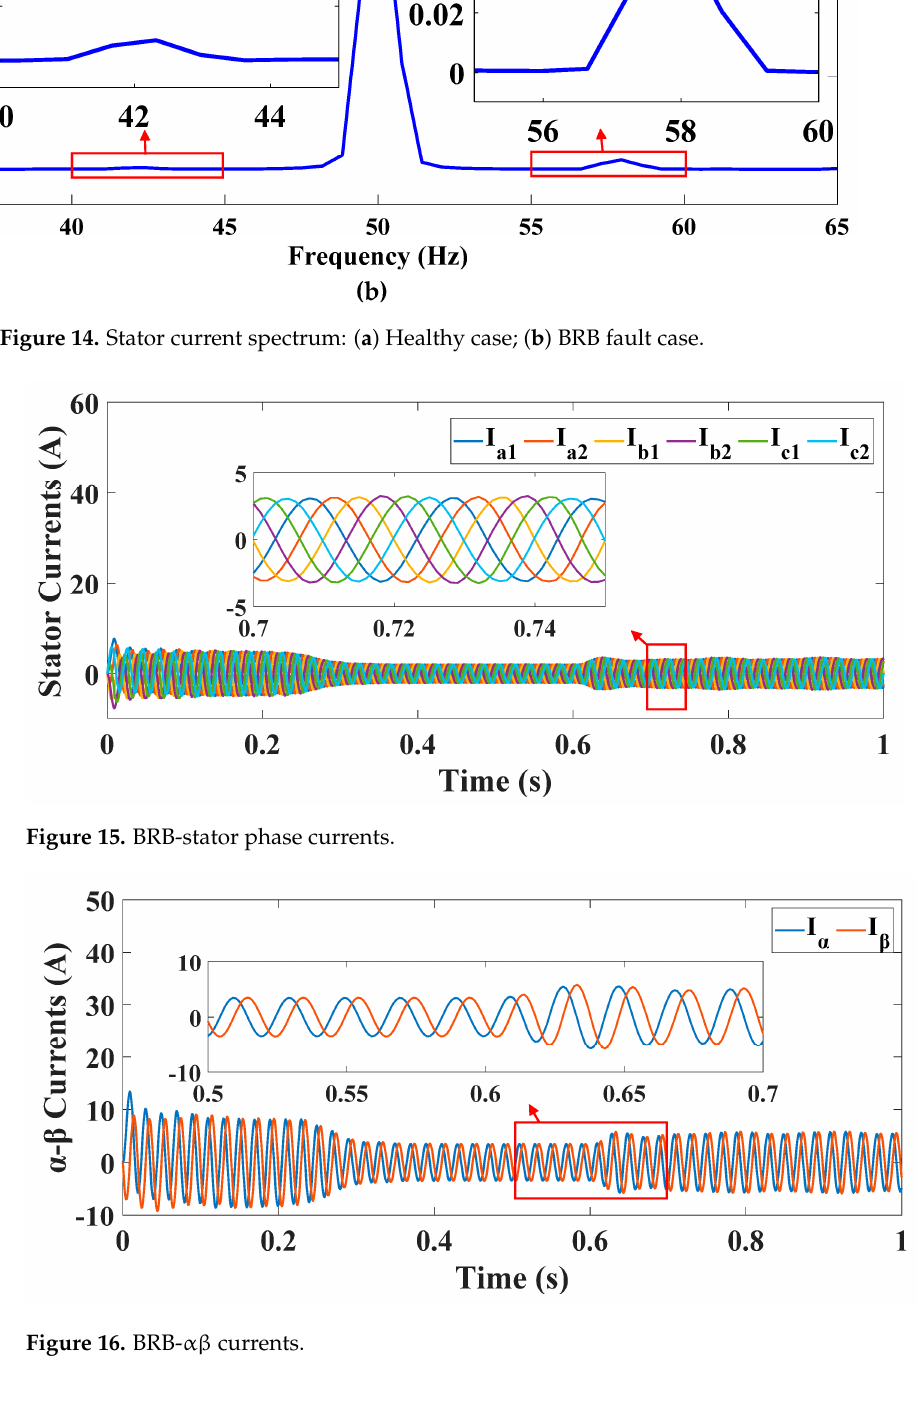
Figure 16. BRB- αβ currents.